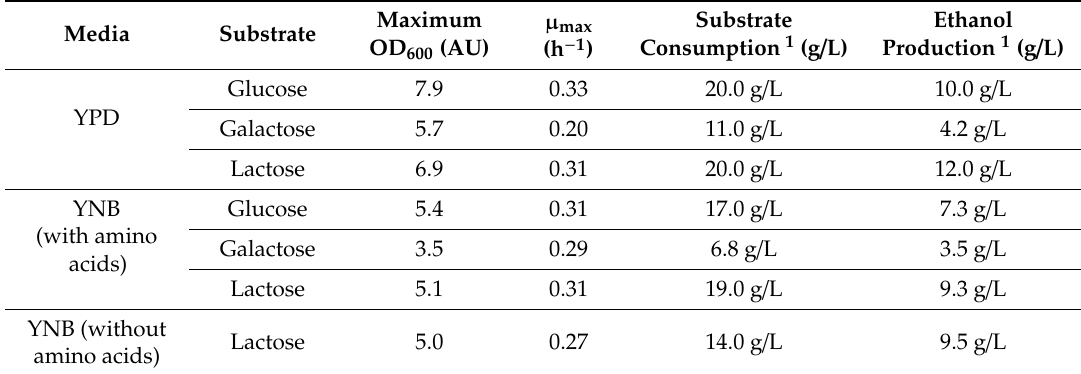
Table 1. Growth characteristics of Kluyveromyces lactis in di ff erent media.